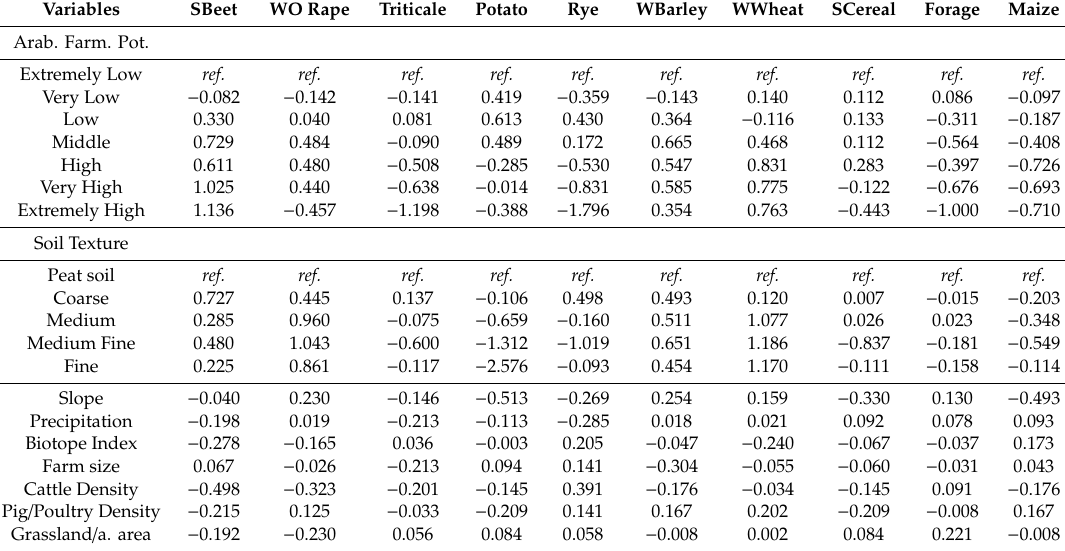
Table 3. The log odds values describe the likelihood of crop occurrence when the variable value changes by one unit, while all other variable stay stable. The positive / negative sign shows the direction of relationship; ref. is the reference category of the ordinal variables. SBeet WO Rape Triticale Potato Rye WBarley WWheat SCereal Forage Maize Arab. Farm.